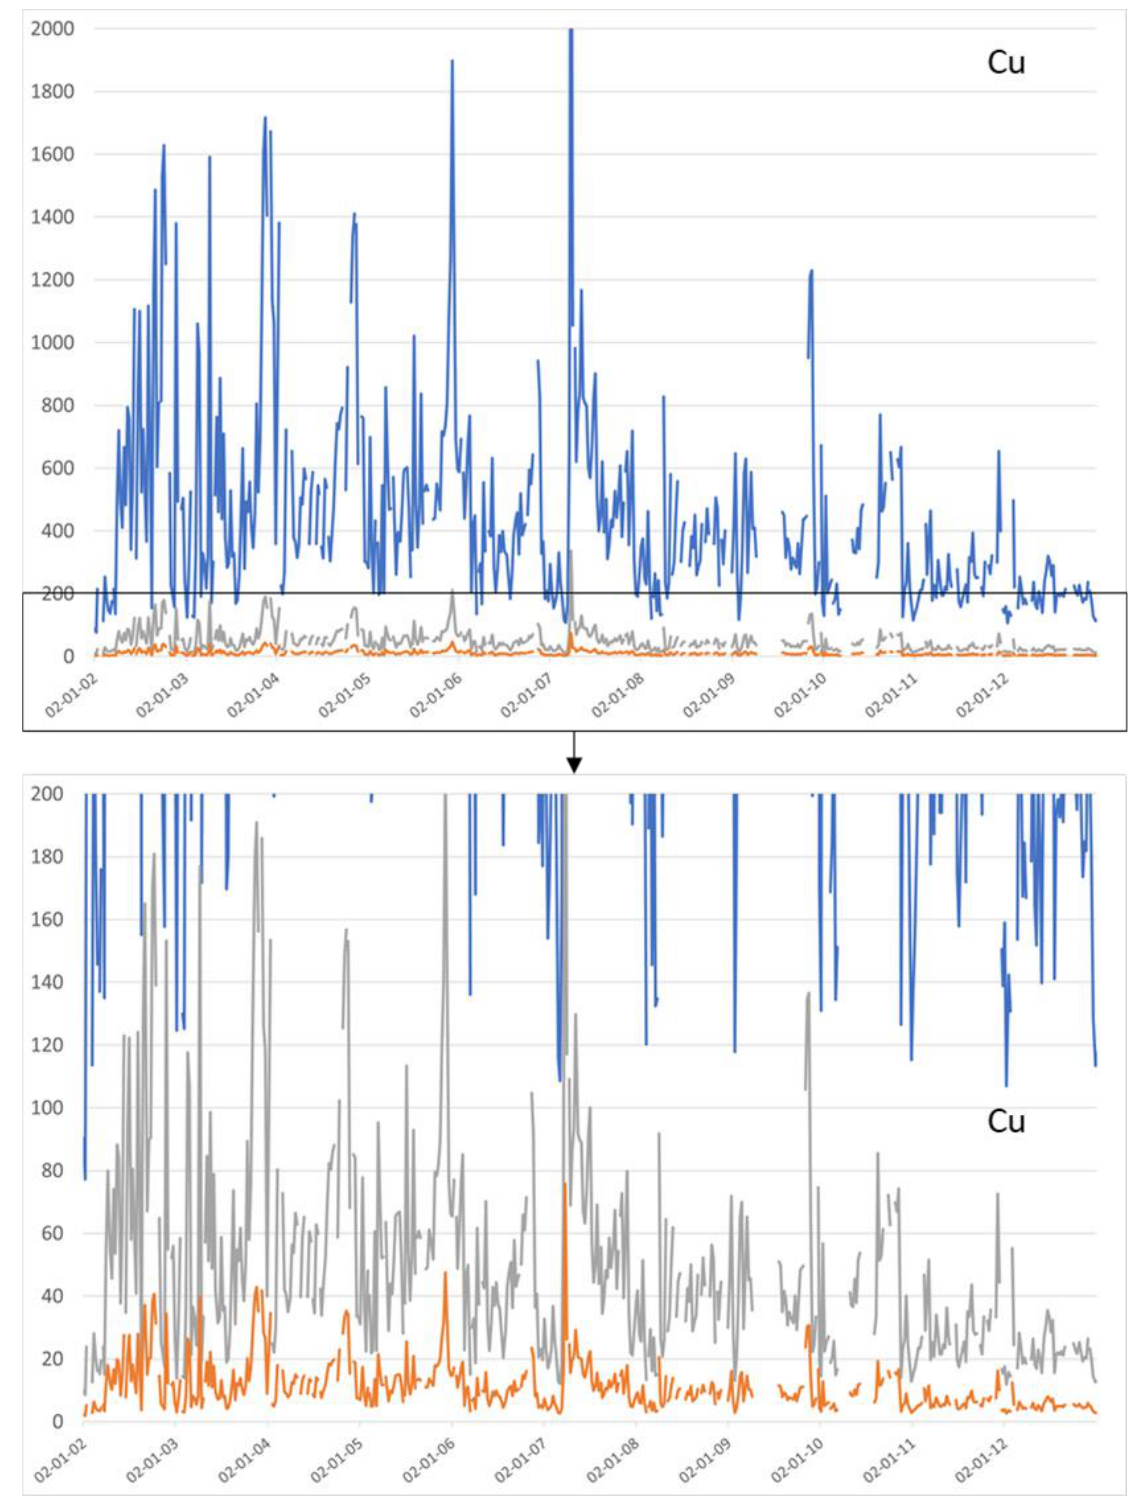
Figure 4. Copper mass concentrations (mg/kg) at Eijsden (Meuse river) of the suspended sediment: clays = particles < 2 µm (average diameter = 1 µm), fine silts = 2 µm < particles < 16 µm (average diameter = 9 µm) and coarse silts = 16 µm < particles < 63 µm (average diameter = 40 µm). The top figure ’s y-axis scale from 0 to 2000 mg/kg; the bottom figure ’s y-axis scale from 0 to 200 mg/kg.